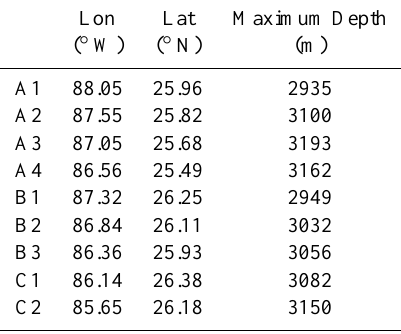
Table 1. Location (longitude and latitude) and maximum depth (m) of the moorings along the US–Mexico boundary of the